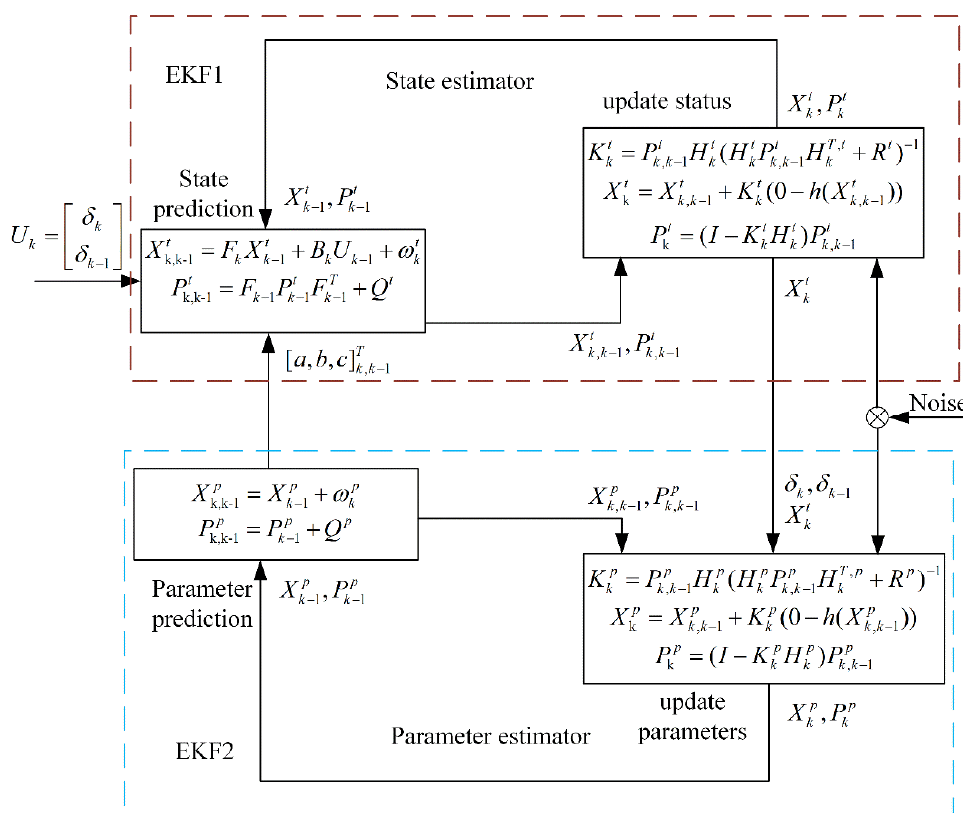
Figure 8. Workflow chart of proposed DEKF.